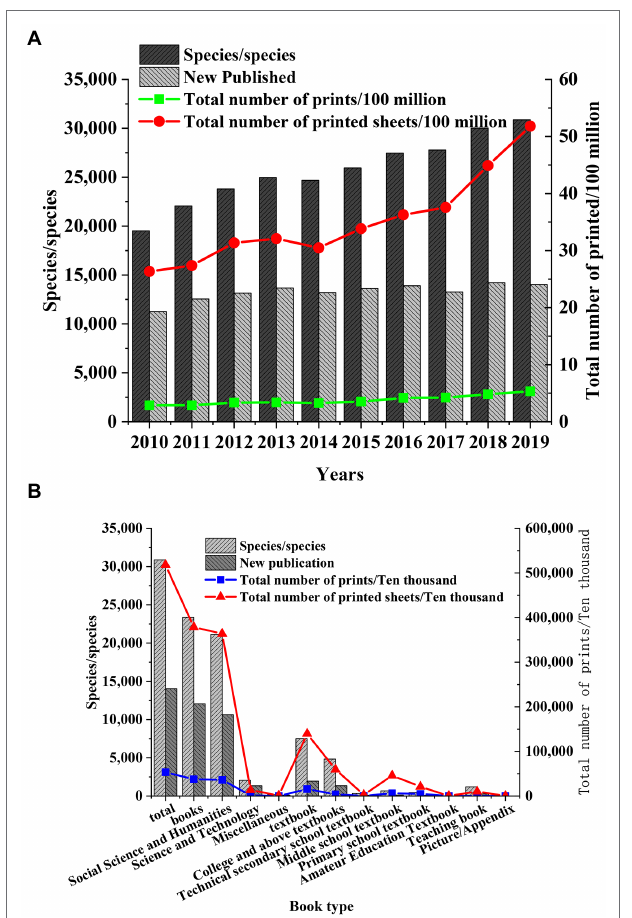
FIGURE 3 | Number of journals published in Shanghai. (A) Number of Shanghai journals published in 2010. (B) Types of Shanghai journals published in 2019.